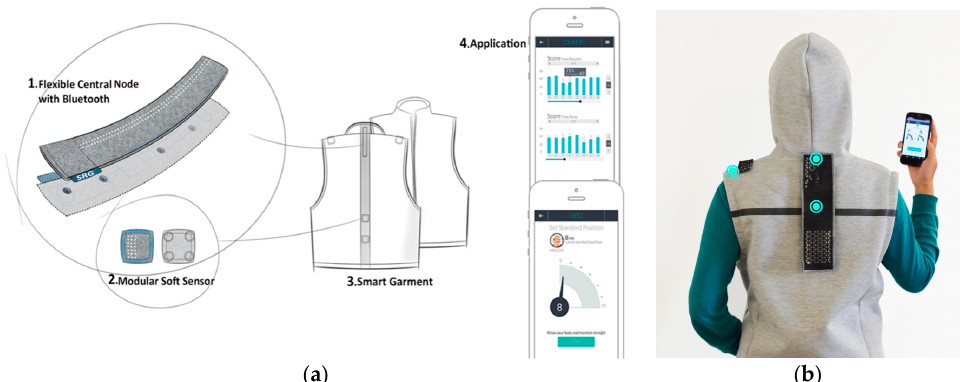
Figure 4. System concept overview of Zishi : ( a ) Concept illustration; ( b ) User wearing the garment, blue dots show the sensor positions.